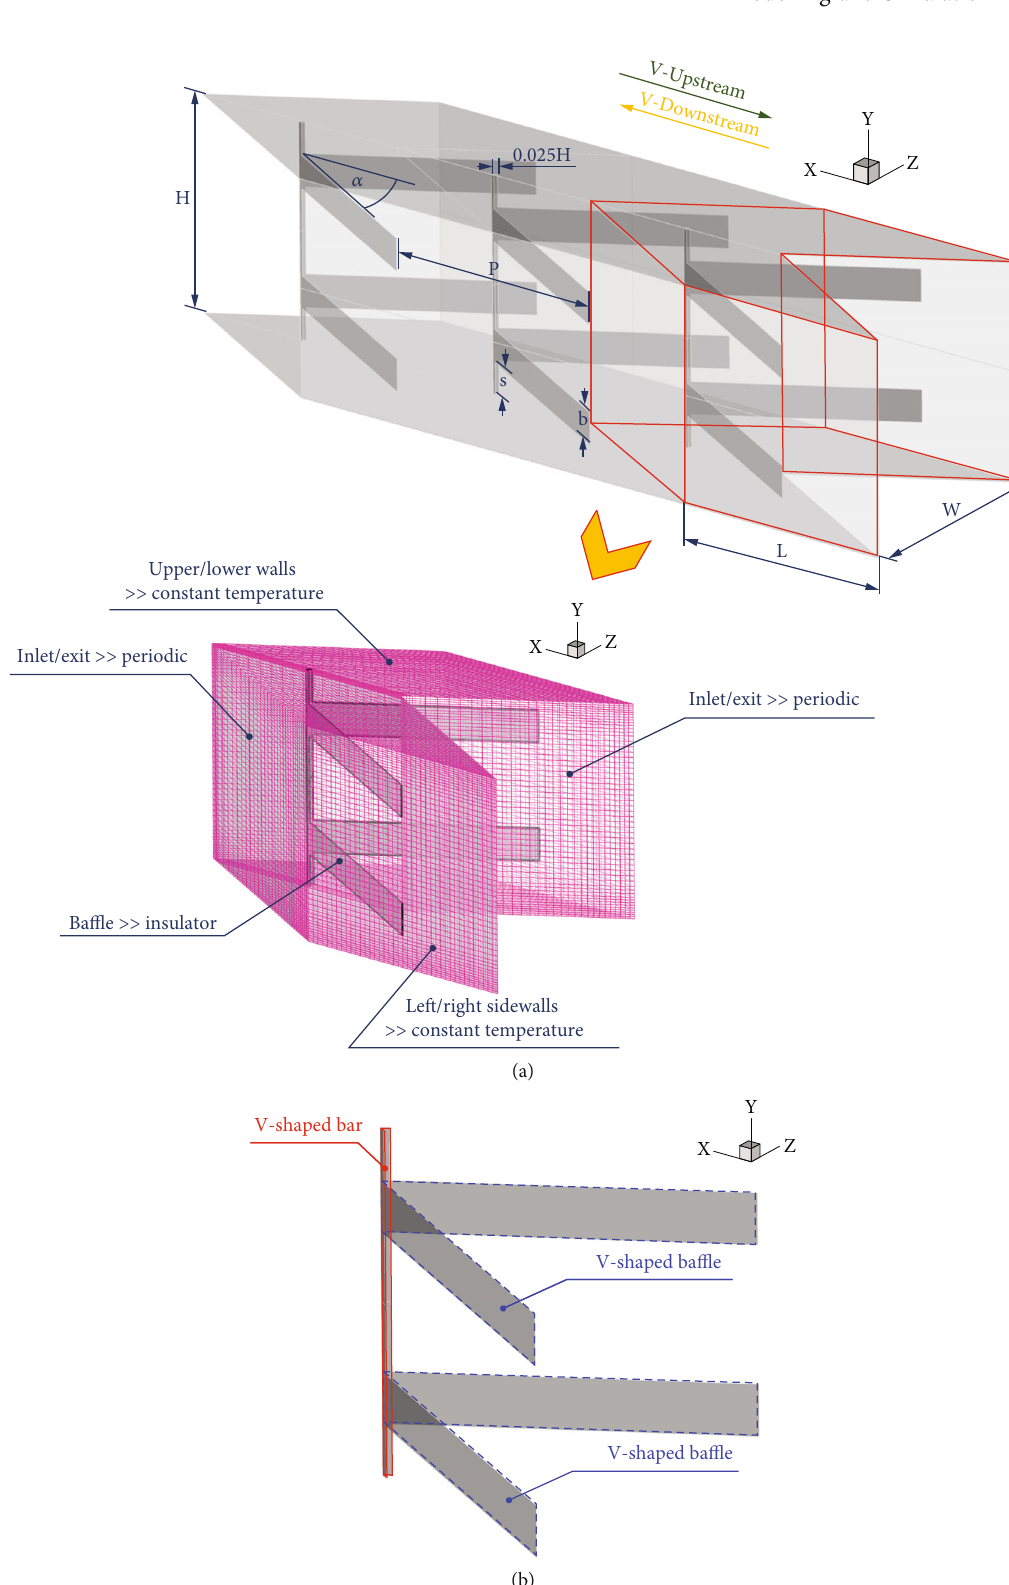
Figure 1: Physical domain of (a) ba ffl ed duct and (b) ba ffl e con fi